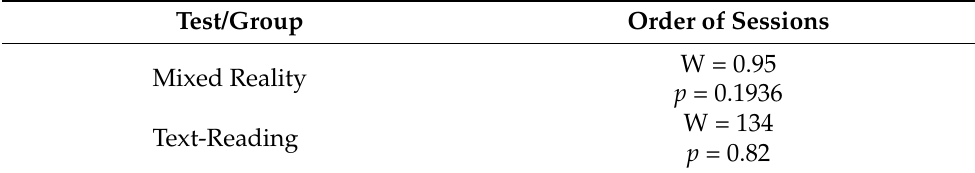
Table 2. Results (statistic W and p -value) of retentive score on different sessions order obtained throughout the Wilcoxon Sum Rank Test.